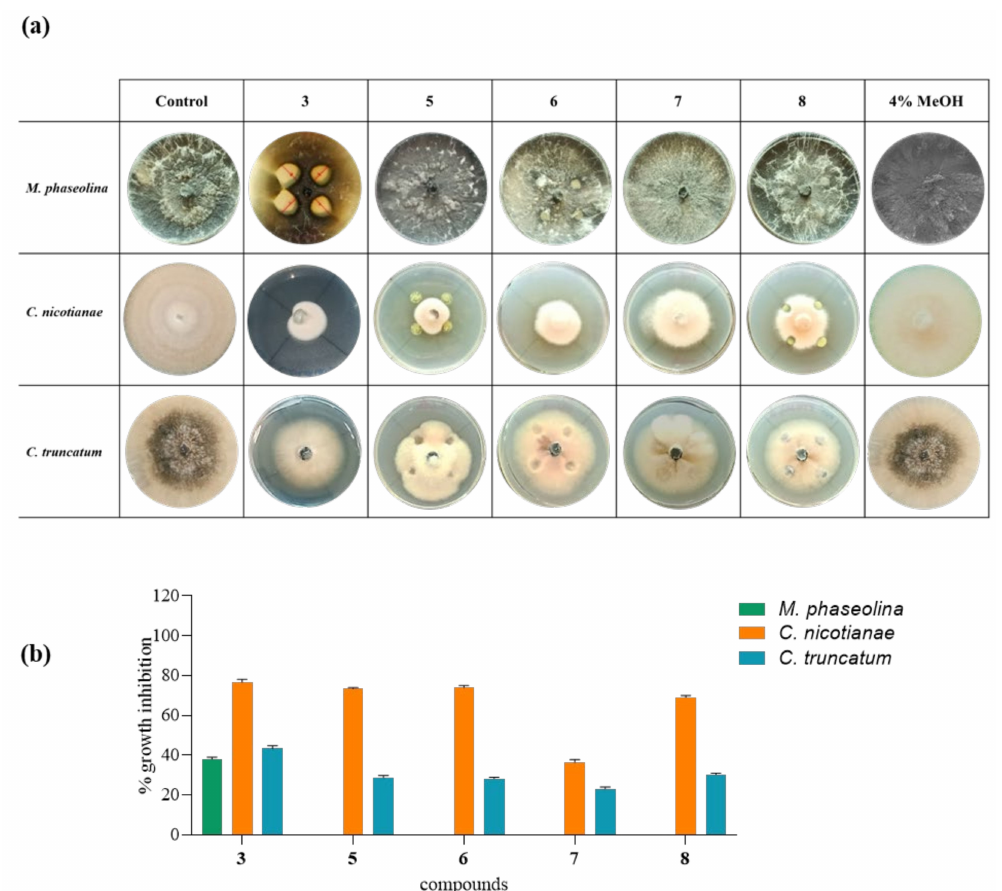
Figure 7. Effects of PCA ( 3 ) and phenazine derivates ( 5 – 8 ) against M. phaseolina, C. nicotianae , and C. truncatum . The graphic shows the fungal inhibition growth by tested compounds at a concentration of 25 µ g/mL. ( a ) Representative photos of the biological assay for in vitro inhibition of mycelial growth of M. phaseolina , C. nicotianae , and C. truncatum . The positive controls were fungi grown on PDA plates, and the negative control was 4% MeOH. ( b ) Inhibition of fungal growth reported as the percentage reduction in the diameter of the fungal mycelia in the treated plate compared to that in the control plate. 3 = phenazine-1carboxylic acid (PCA); 5 = 2-nitrophenazine; 6 = 1,3-nitrophenazine; 7 = 1,9-dinitrophenazine; 8 = 2,9-dinitrophenazine. Data are presented as means ± standard deviation ( n = 3) compared to control fungi grown alone. For comparative analysis of groups of data, one-way ANOVA was used; p -values were extremely significant ( p < 0.0001). Table 1. The MIC 50 of PCA ( 3 ), phenazine ( 1 ), and phenazine derivates ( 5 – 8 ) against M. phaseolina